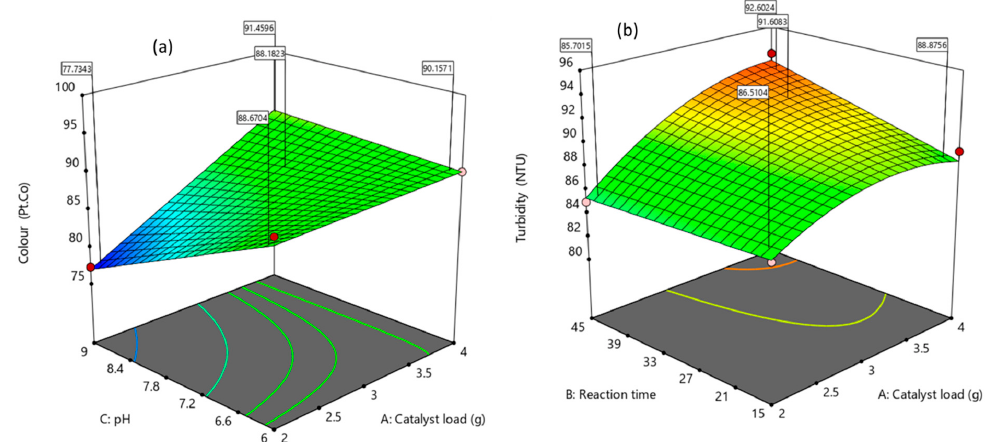
Figure 6. Response surface 3D plot of catalyst load and pH effects on ( a ) color and ( b ) turbidity removal.